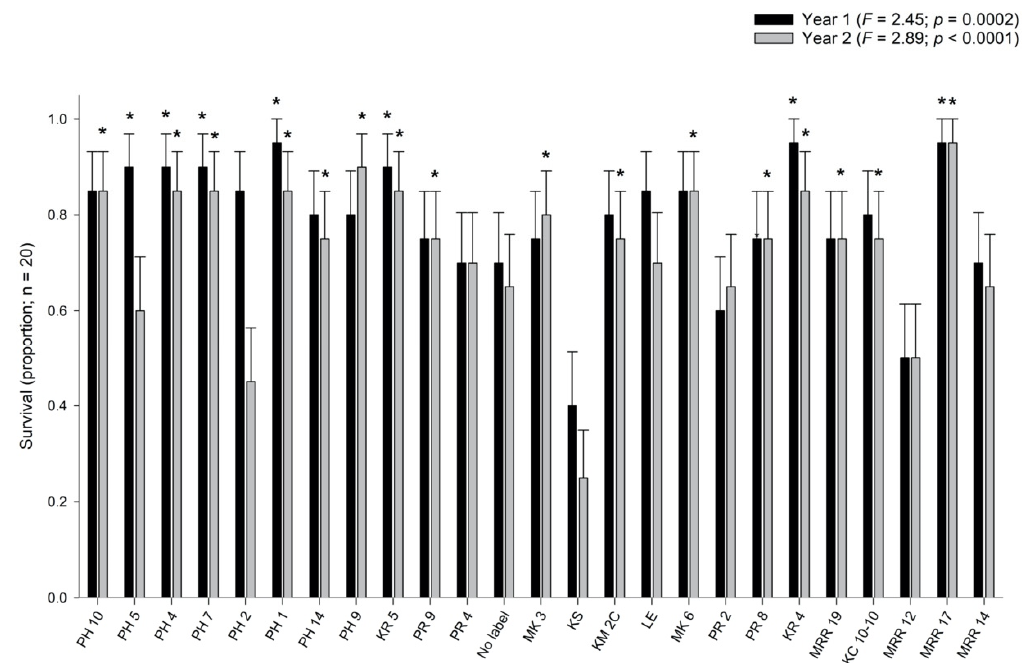
Figure 1. First and second year survival (mean ± SE) across 25 Acacia koa A. Gray families after field establishment. Asterisks indicate a significant difference in survival among replicates within a family compared to Kauai susceptible (KS) control within a given year as determined by analysis of variance via generalized linear mixed models.